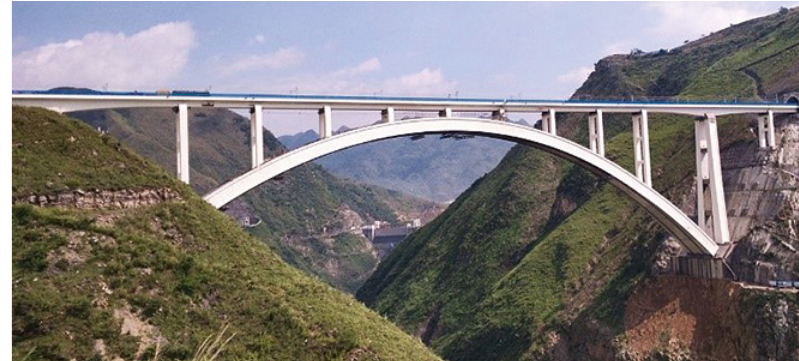
Figure 1. Overview of Beipanjiang